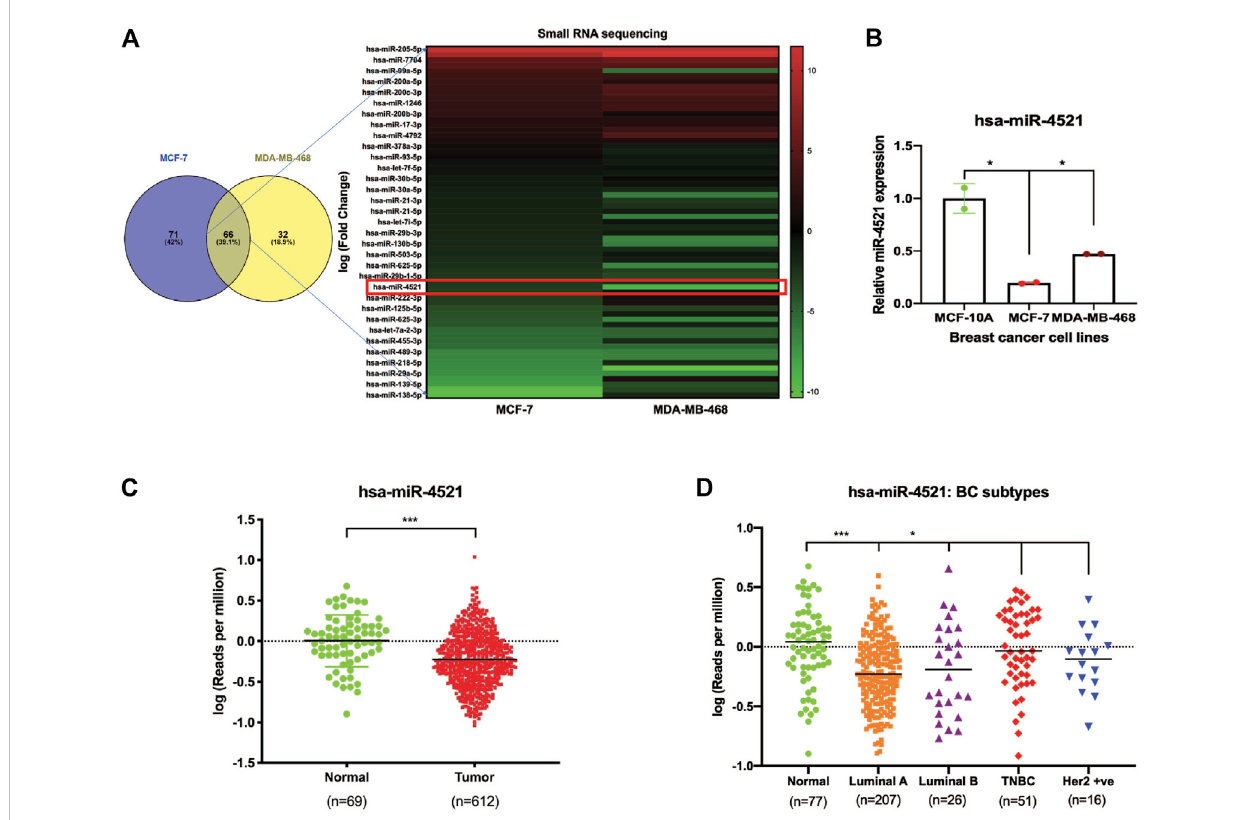
FIGURE 1 Expression of miR-4521 is signi fi cantly downregulated in breast cancer cell lines and TCGA-BRCA breast cancer patient samples. (A) miRNA sequencing identi fi ed miR-4521 as signi fi cantly downregulated in MCF-7 and MDA-MB-468 cell line when compared to MCF-10A cell line. (B) qRT-PCR expression analysis of miR-4521 in MCF-7 and MDA-MB-468 breast cancer cells compared to MCF-10A cells, RNU6B was used as endogenous control for miR-4521. Relative quantity (RQ) was calculated using the formula 2 − ΔΔ CT ; Paired Student ’ s t -test (two-tailed) was performed between control MCF-10A and each breast cancer cell lines, * p < 0.05, ( n = 2). (C) TCGA-BRCA datasets from TCGA, Pan Cancer Atlas showing downregulation of miR- 4521 in tumor samples when compared to normal. (D) TCGA-BRCA datasets from TCGA, Pan Cancer Atlas showing downregulation of miR-4521 in patients with different breast cancer subtypes (Luminal A, Luminal B, TNBC, and Her2 positive) when compared to